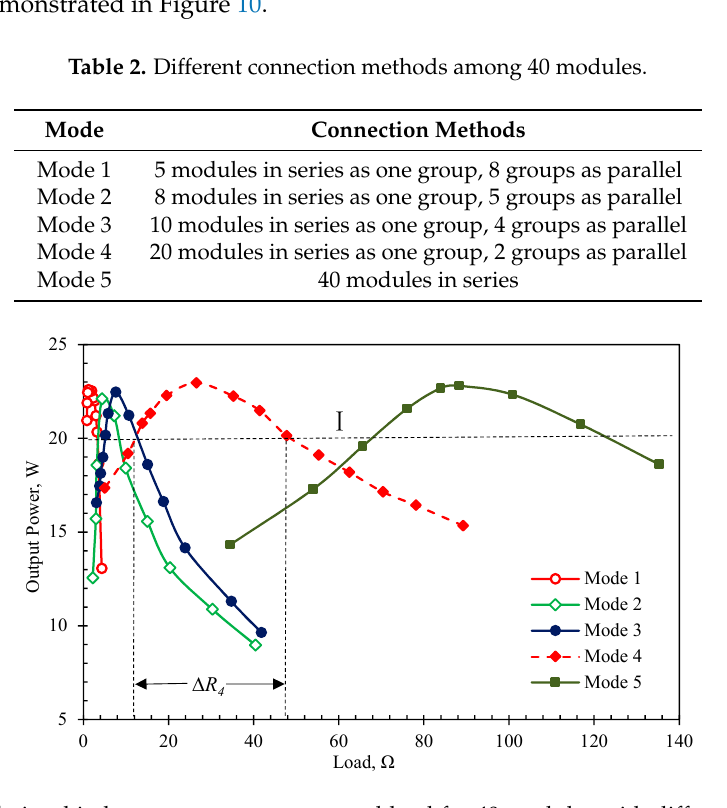
Figure 10. Relationship between output power and load for 40 modules with different connection methods ( ∆ T is 80 °C).